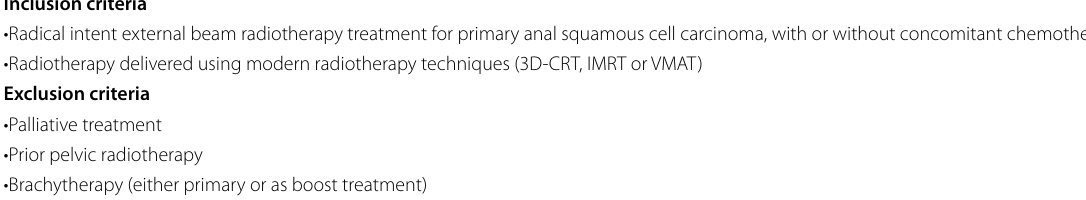
Table 1 Participant inclusion and exclusion criteria Inclusion